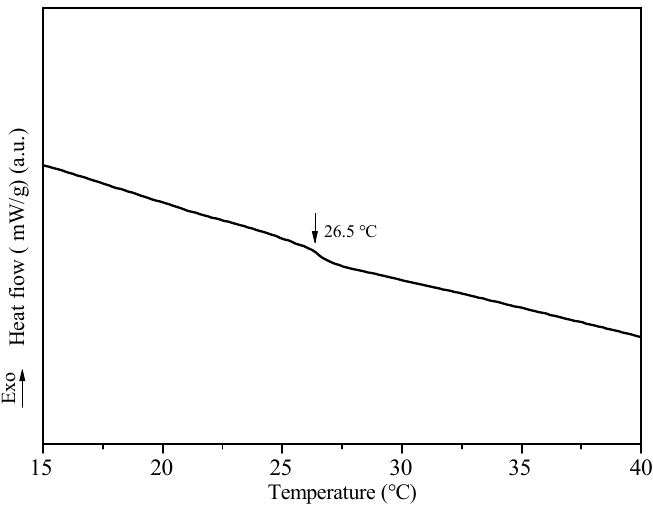
Figure 10. The DSC curve of the copolymer (PBMA- co -PHEMA- co -PDMAEMA- co -PNIPAm).